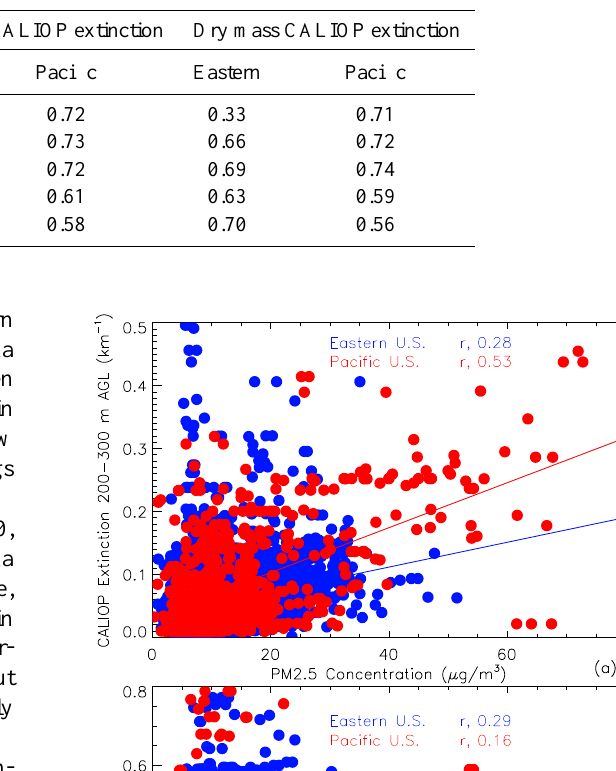
Table 5. Two-year (2008–2009) correlation coefficients of hourly PM 2 . 5 observations and 40km average CALIOP extinction (both uncor- rected and dry mass) at various 100m a.g.l. atmospheric layers.